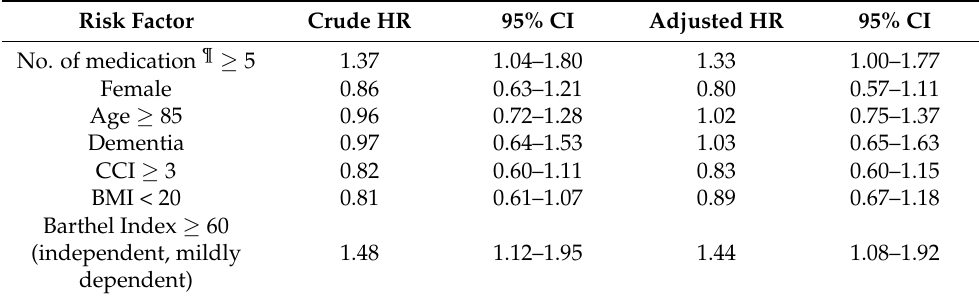
Table 3. Hazard ratios of fall occurrence from Cox proportional hazard models.